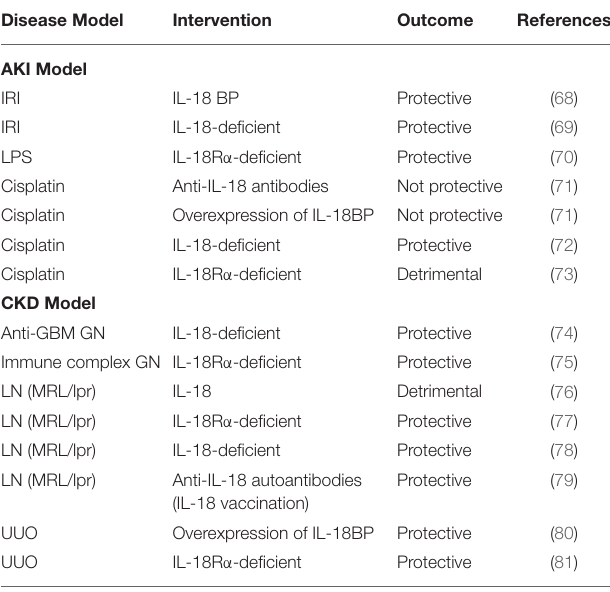
TABLE 1 | IL-18 in renal disease models. Disease